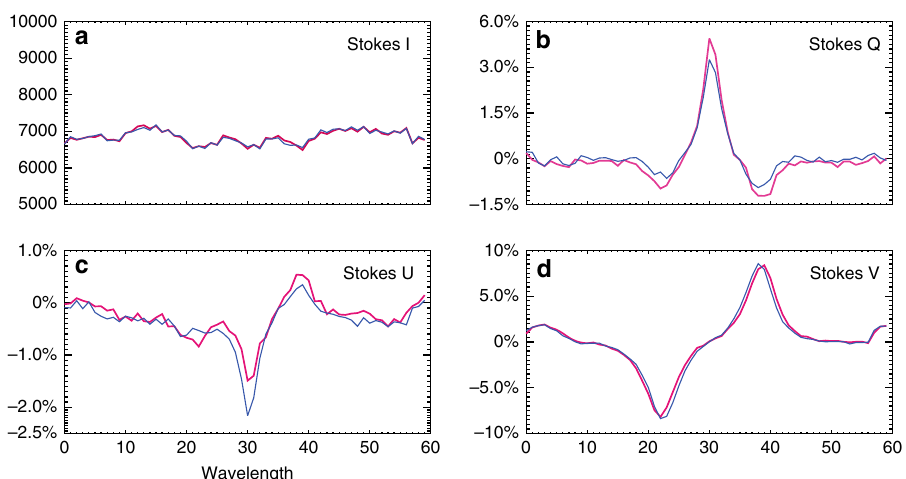
Fig. 5 Stokes pro fi les before and during the fl are. Stokes components (I, Q, U, and V) taken near R3 before (blue) and during (pink) the fl are. a Stokes I. b Stokes Q. c Stokes U. d Stokes V. It is clear that the Stokes I and V components remain almost unchanged but Q and U components are signi fi cantly affected during the fl